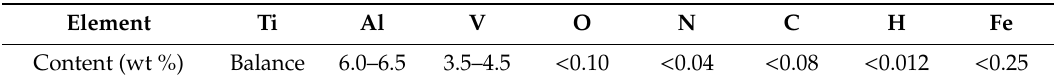
Table 1. Chemical composition of the Ti-6Al-4V alloy powder. Element Ti Al V O N C H Fe Content (wt %)